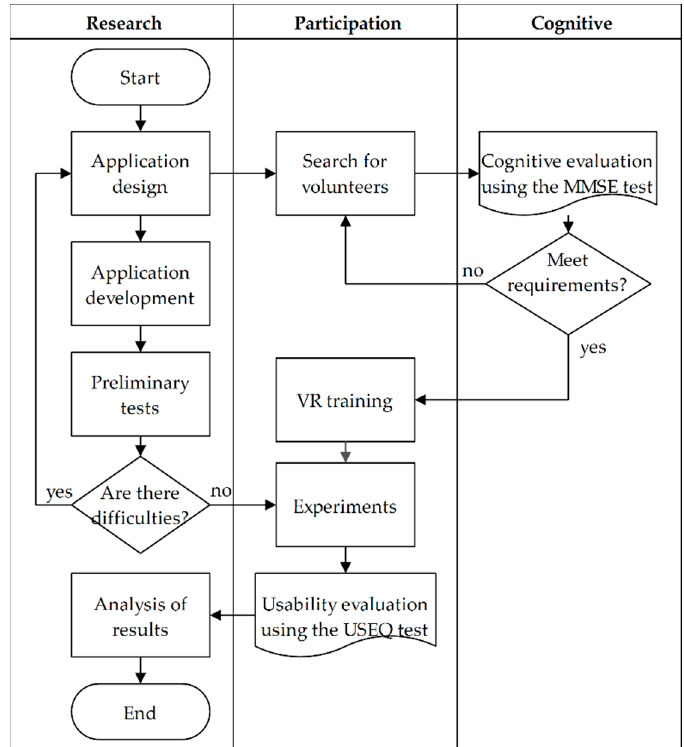
Figure 7. Process diagram of the activities carried out.